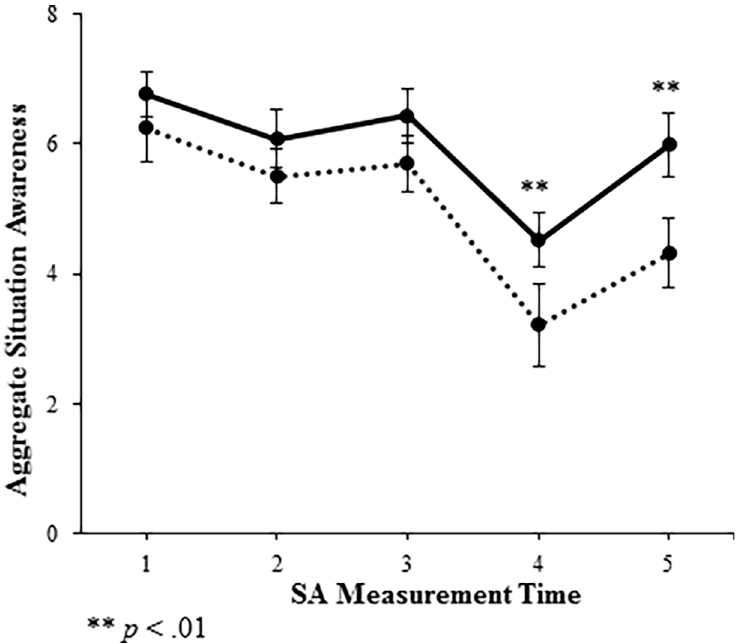
Fig 2. Aggregate SA scores across measurement intervals for PRE and POST scenarios. Dotted line is PRE, Solid line is POST.